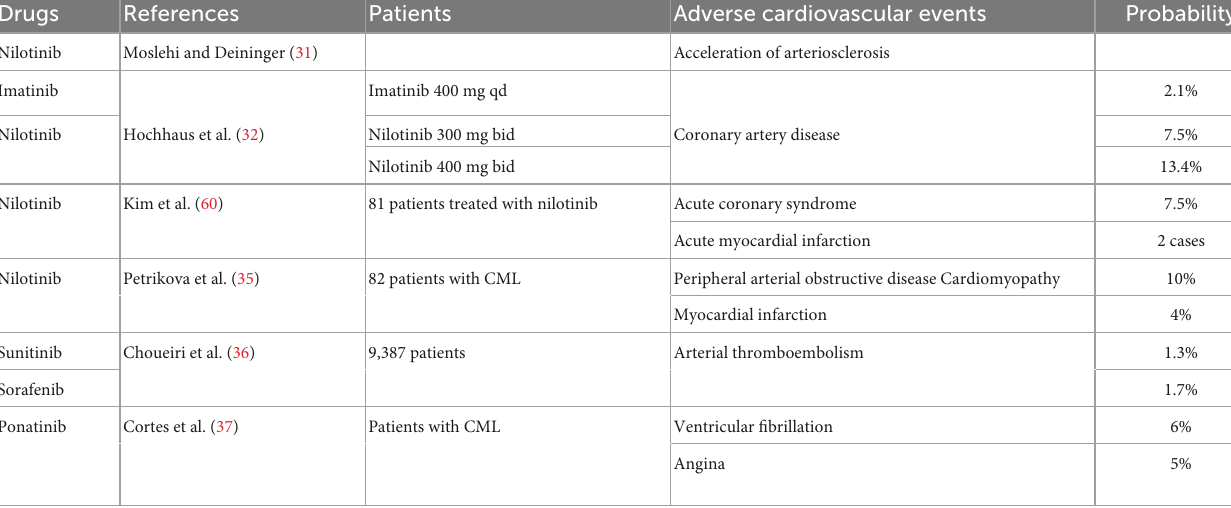
TABLE 3 Summary of clinical studies on cardiotoxicity of tyrosine kinase inhibitors.